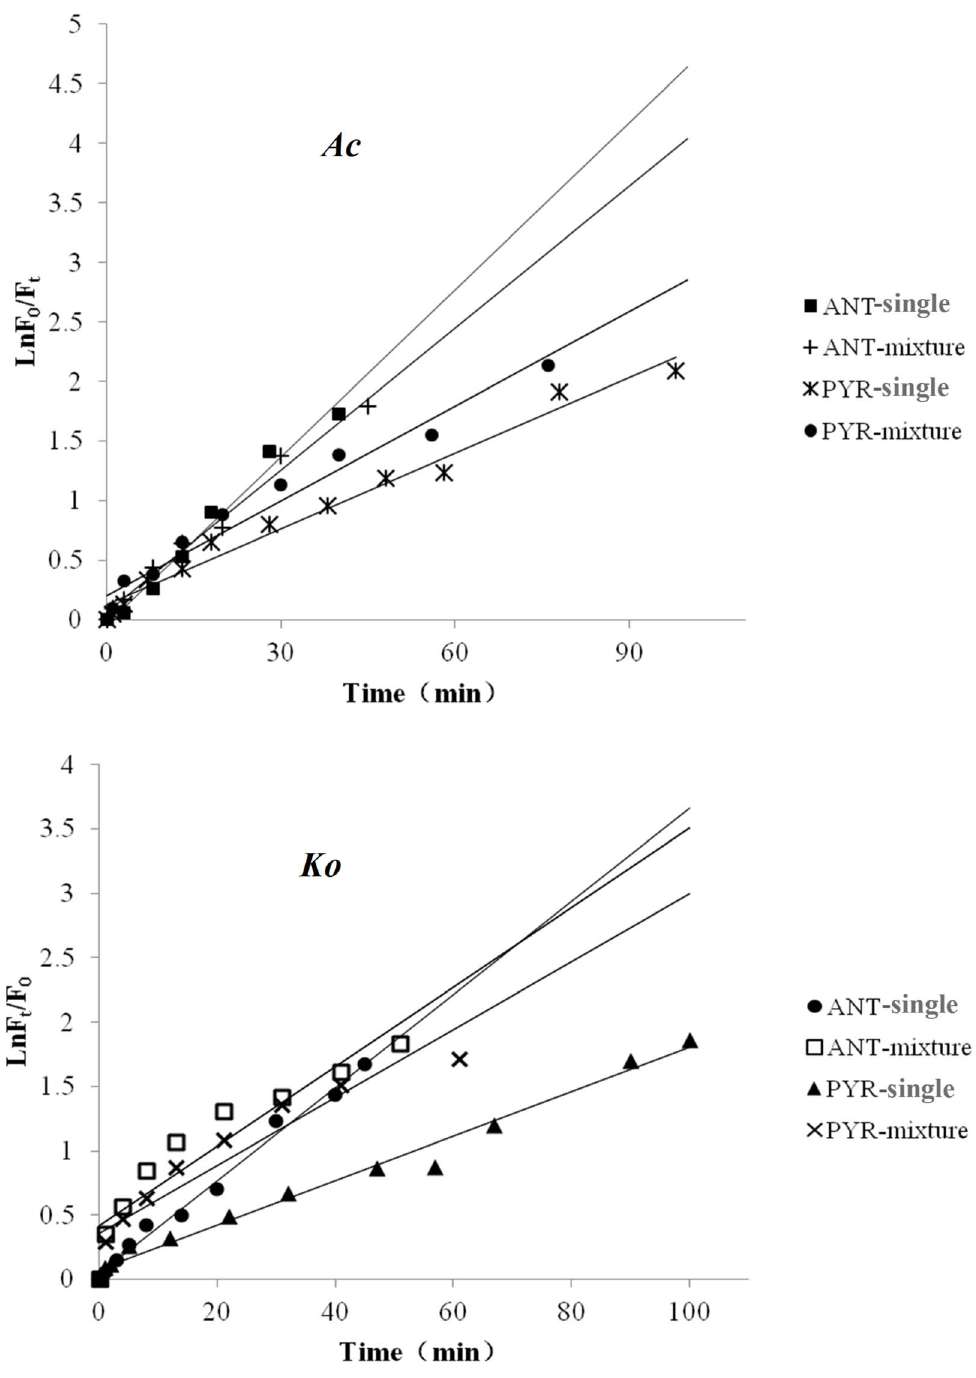
Figure 4. First-order kinetic plots of the photodegradation of ANT (0.25 nmol spot 2 1 ) and PYR (0.25 nmol spot 2 1 ) adsorbed onto Ko and Ac leaves as single component and in multicomponent mixtures. (Table 1). It is assumed that the waxes and lipids on plant leaves can absorb UV photons, which might create light-filtering effects [17,19]. Thus, the number of UV photons striking each PAH adsorbed onto the leaves decreased and thereby reduced the photodegradation rate of each PAH. In this experiment, the leaf- wax content of Ac (4.98 mg.g 2 1 ) was found to be much lower than that of Ko (7.63 mg.g 2 1 ). Thus, the light filtering effect of Ko